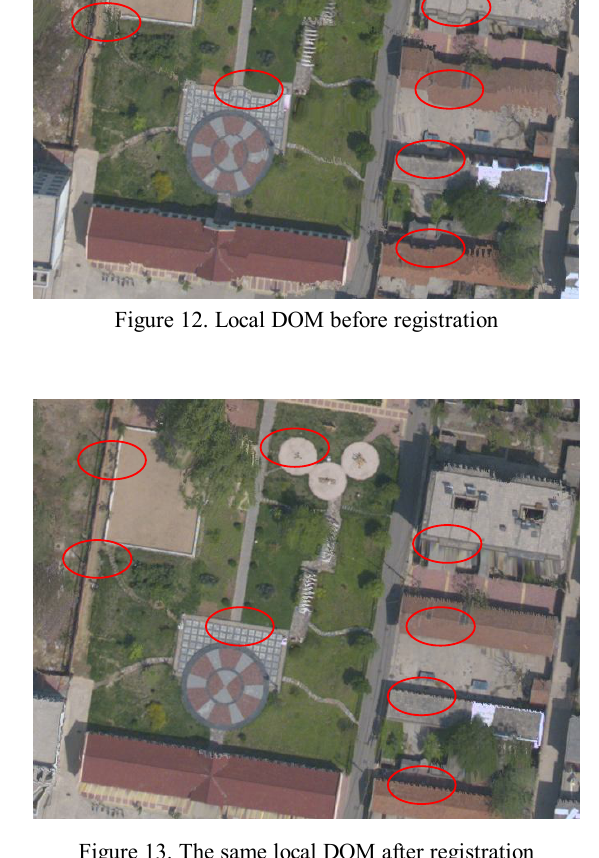
Figure 13. The same local DOM after